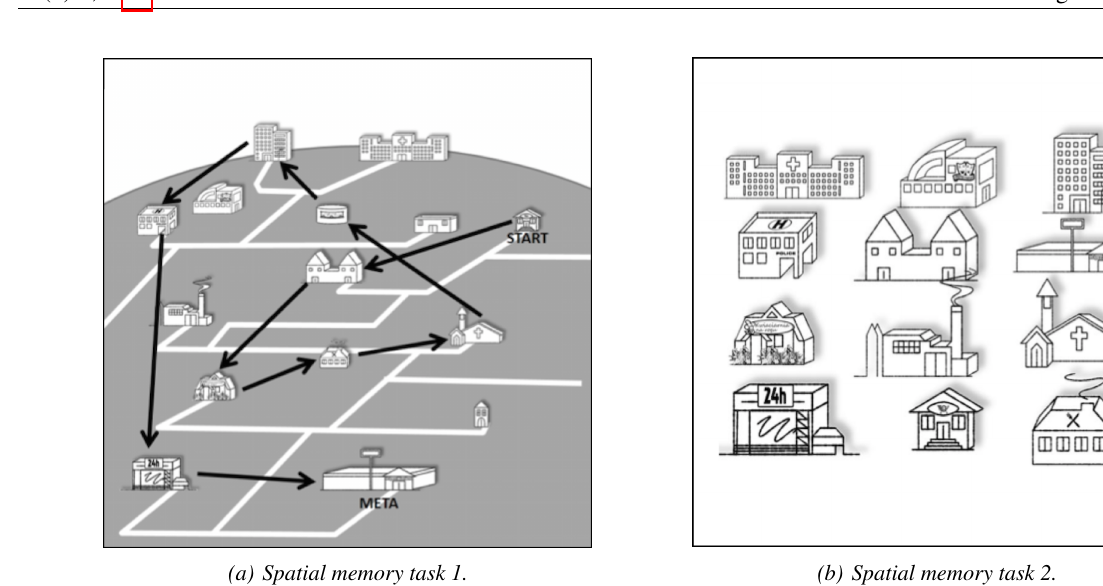
Figure 2 . Examples of spatial working memory capacity tasks. position as well as spatial relations between them. The time limit of this task was 45 seconds. During the test phase the task was to enter numbers assigned to each building in the proper empty spots on the answer sheet. All correct entries were summed for the final score ranging in [0 ,